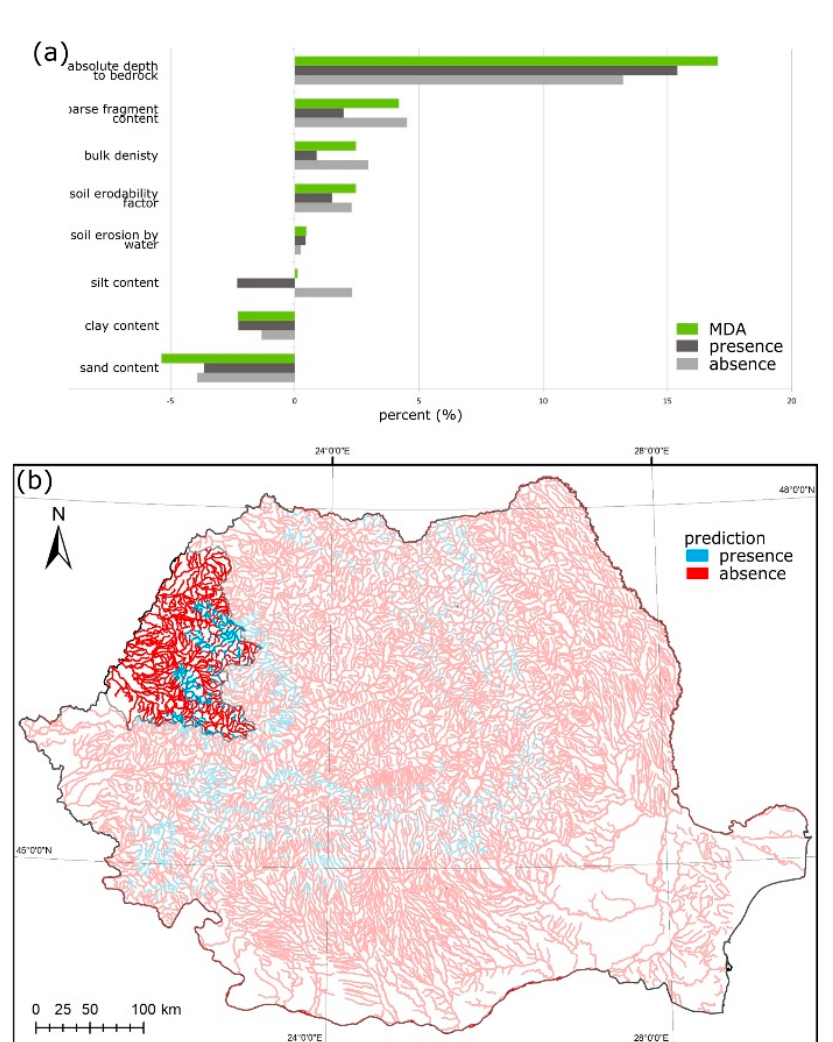
Figure 2. ( a ) Mean decrease in accuracy of soil-related factors for predicting Austropotamobius bihariensis species distribution. ( b ) Prediction map of A . bihariensis species distribution based on soil-related factors. A mask was applied to highlight the results of prediction inside the area of distribution of this species. Table 3. Accuracy metrics for the final distribution maps (OA—overall accuracy; AUC—area under the curve).